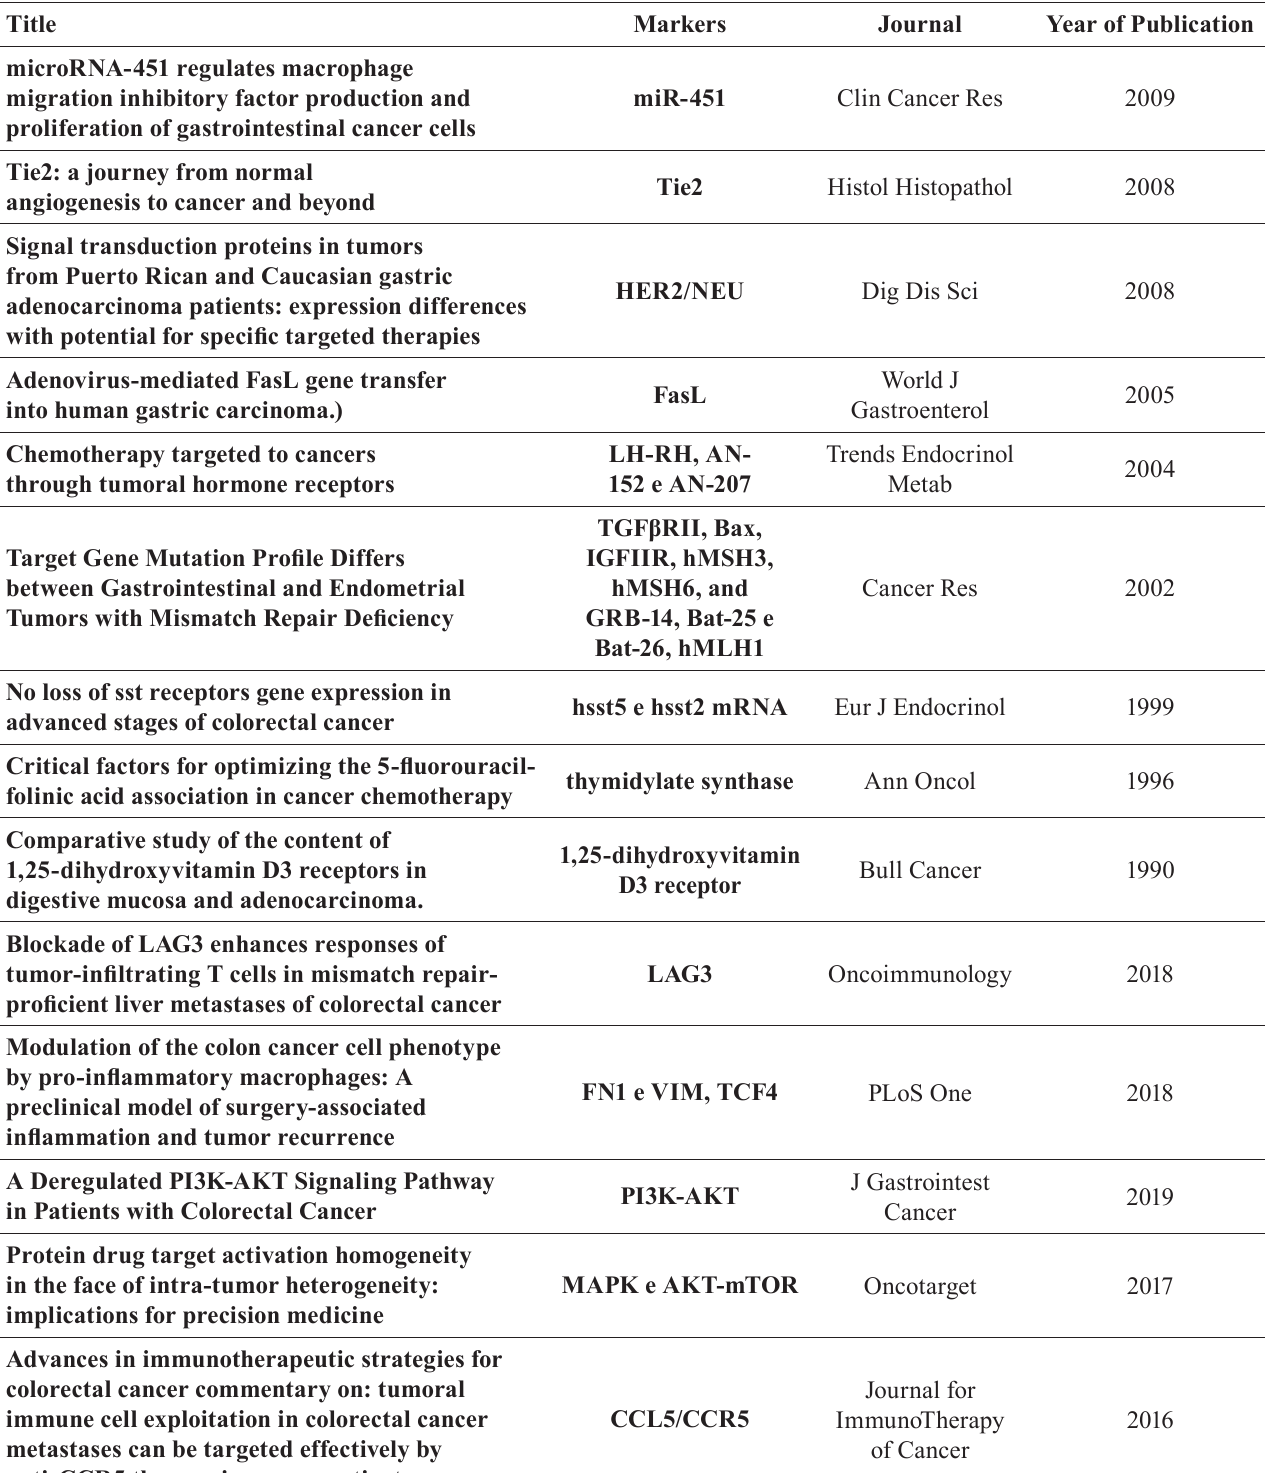
TABLE I - T umor targets of CRC identified in articles searched in PubMed, with their respective journals and year of publication